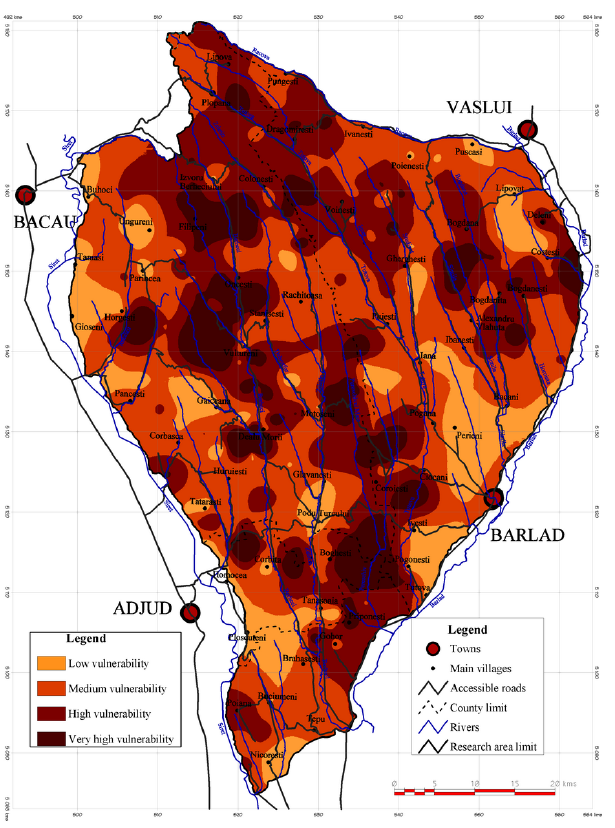
Fig. 5. Vulnerability factor 3: Percentage of arable lands on slopes in Tutova